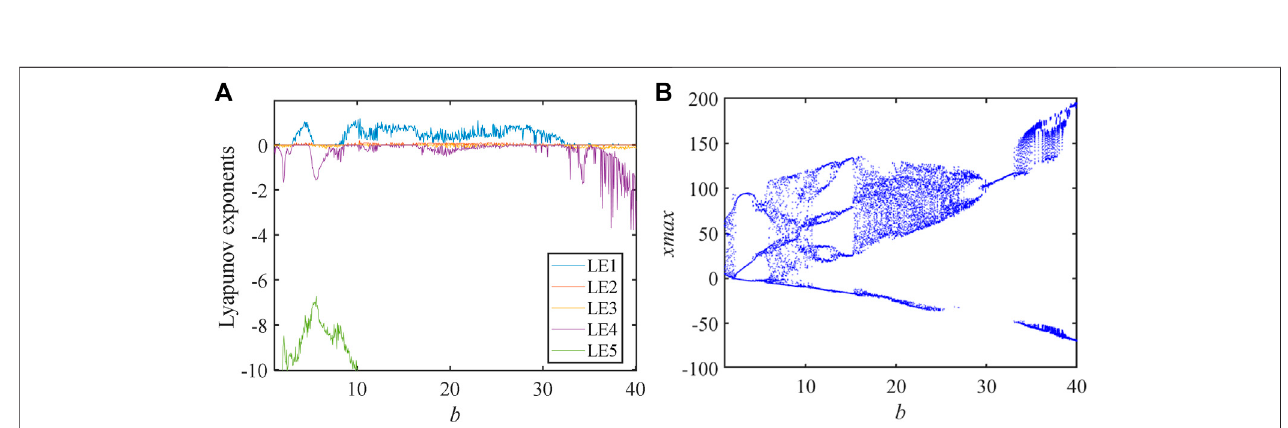
FIGURE 7 | Bifurcation diagram and LEs with parameter b , (A) LEs, and (B) bifurcation diagram.